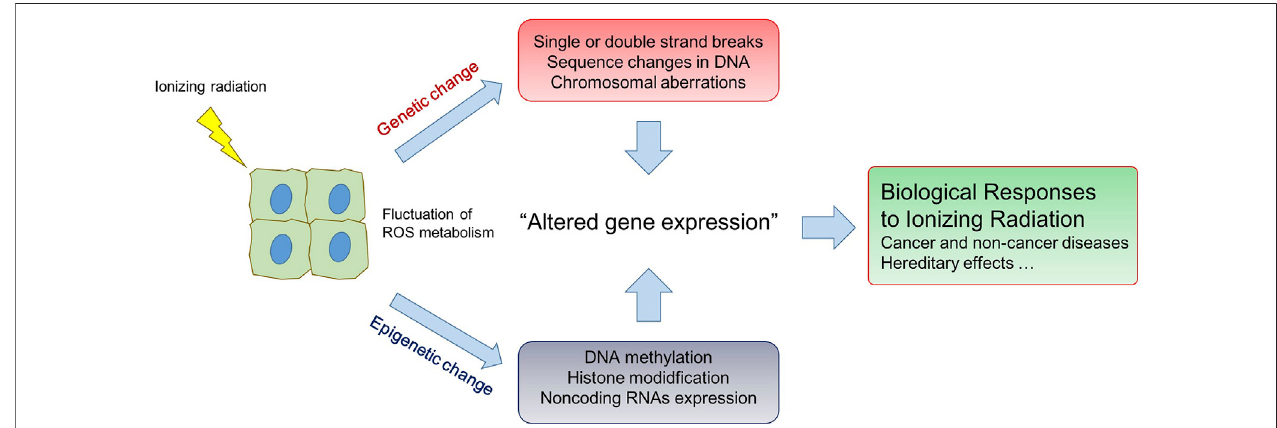
FIGURE 1 | Genetic and epigenetic change of cells responding to ionizing